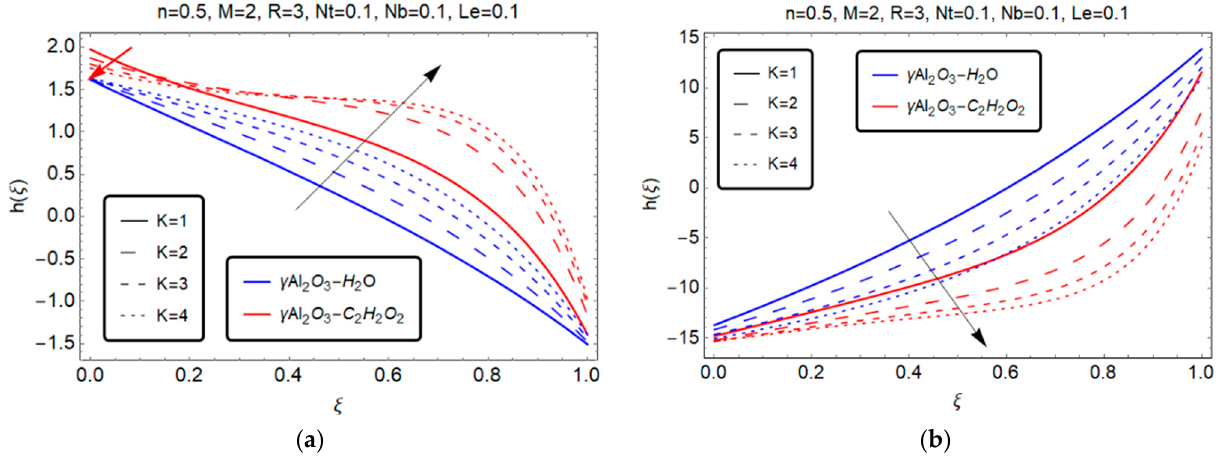
Figure 5. Effect of micropolar parameter 𝐾 on ℎ(𝜉) . ( a ) S > 0; ( b ) S < 0.